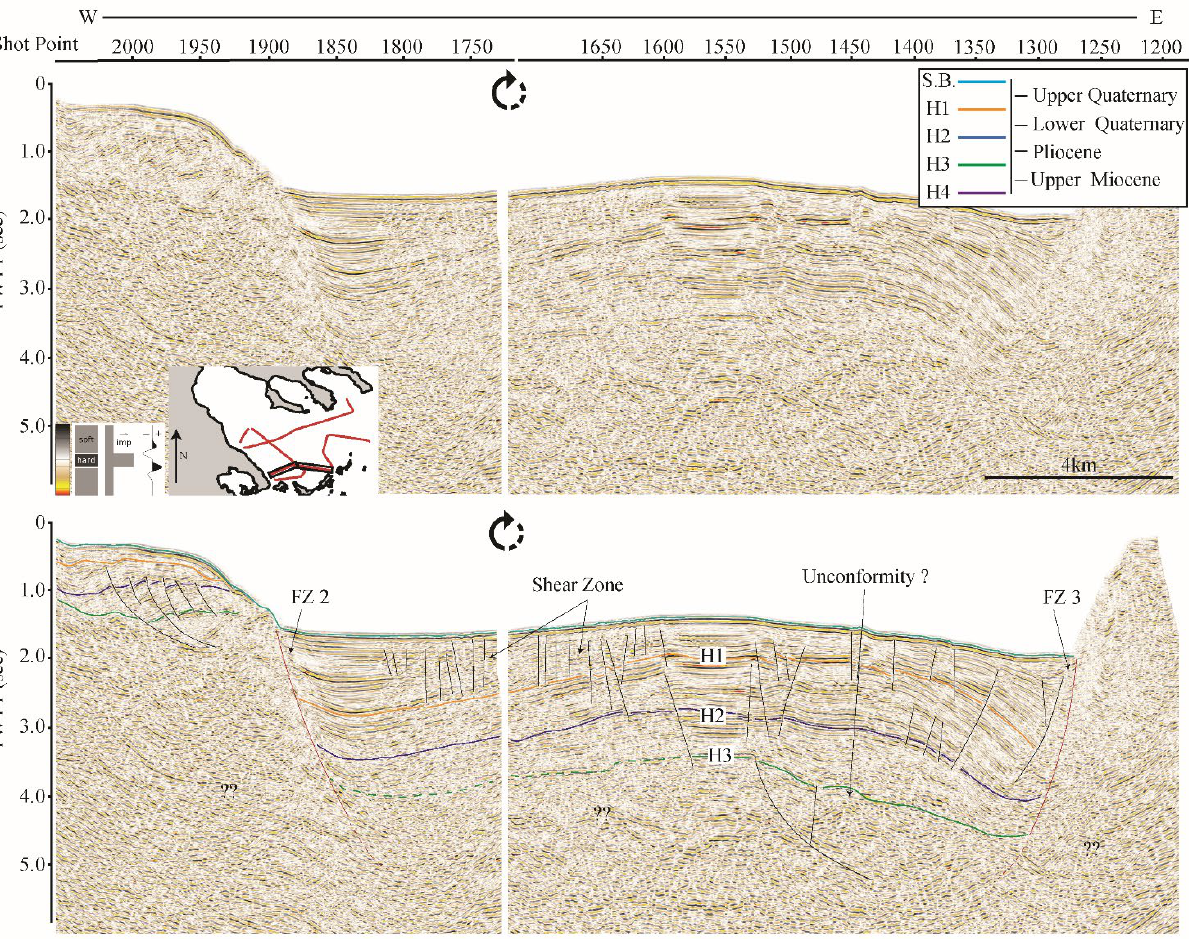
Figure 8. Seismic Line EF-DE. Upper part: un-interpreted set of regional seismic profiles. Lower part: interpreted seismic section with highlighted key horizons and the most prominent tectonic elements.